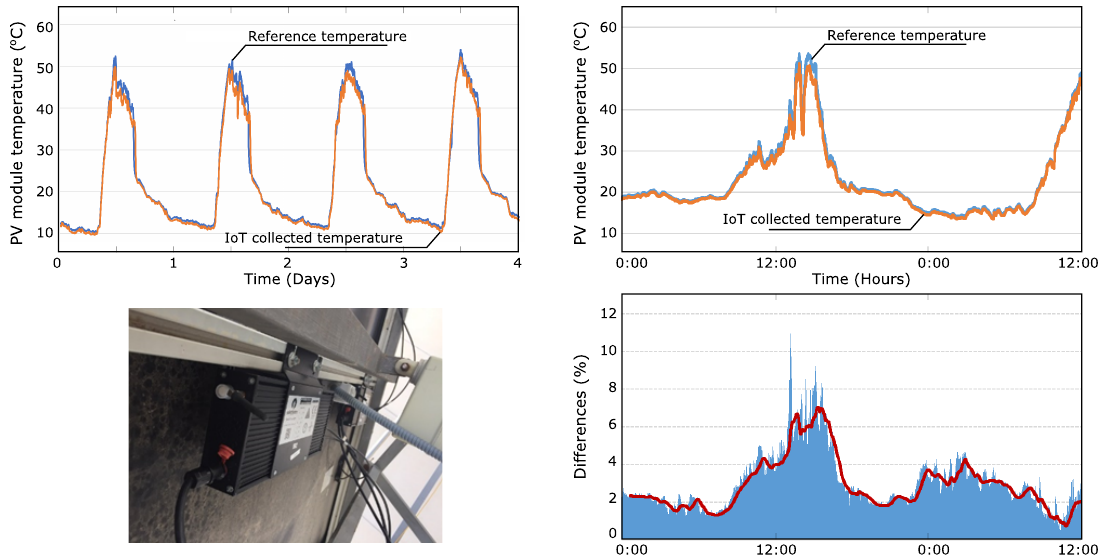
Figure 4. LM35 temperature validation. Example of field-test measurements.